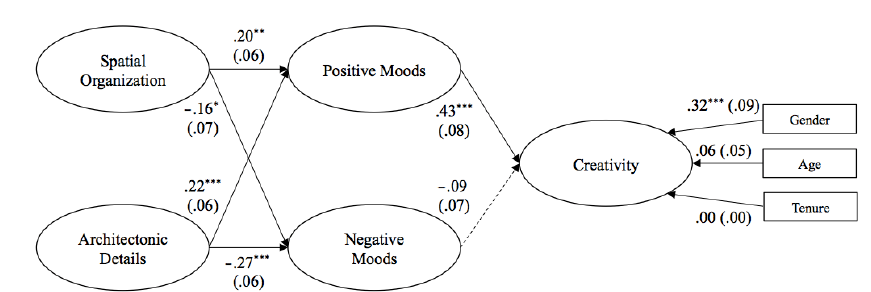
Figure 1. Model results of spatial organization, architectonic details and creativity through positive and negative moods (source: created by authors) Table 3. Estimates of the indirect effects on creativity (source: created by authors) Spatial organization Architectonic details